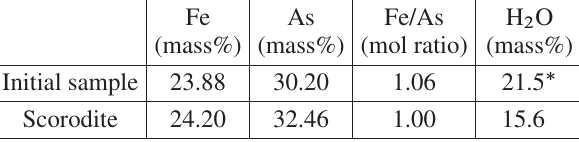
Table 2. Measured concentrations of the initial sample